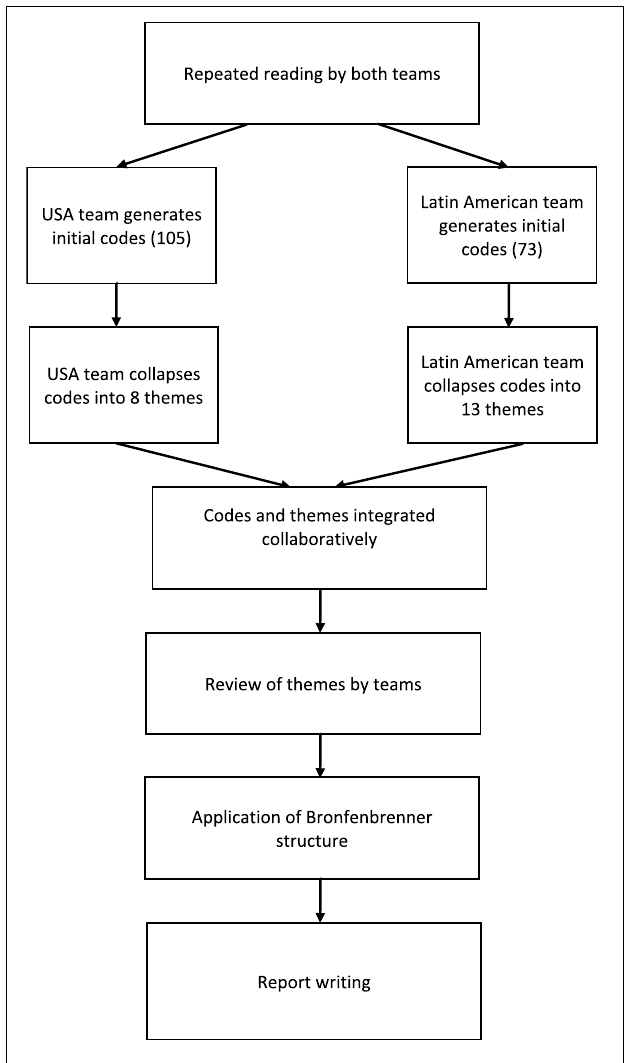
FIGURE 1 | The coding